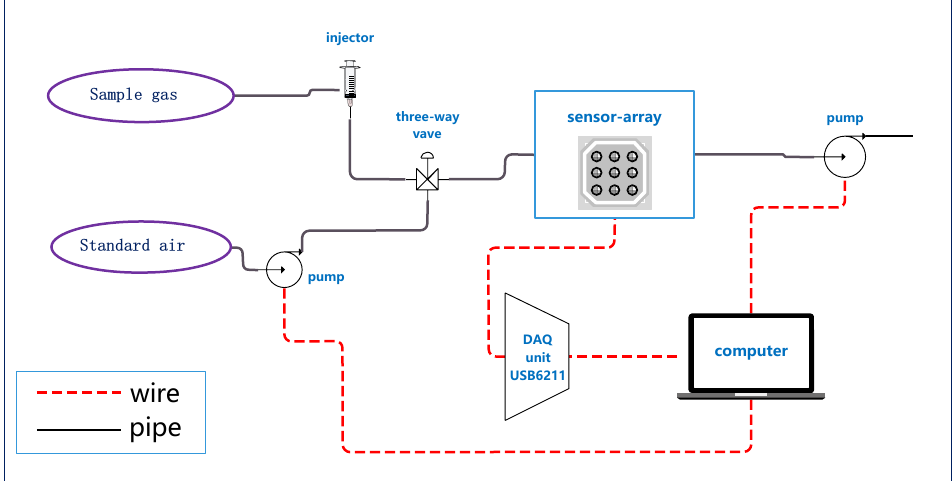
Figure 1. The structure of the self-assembled